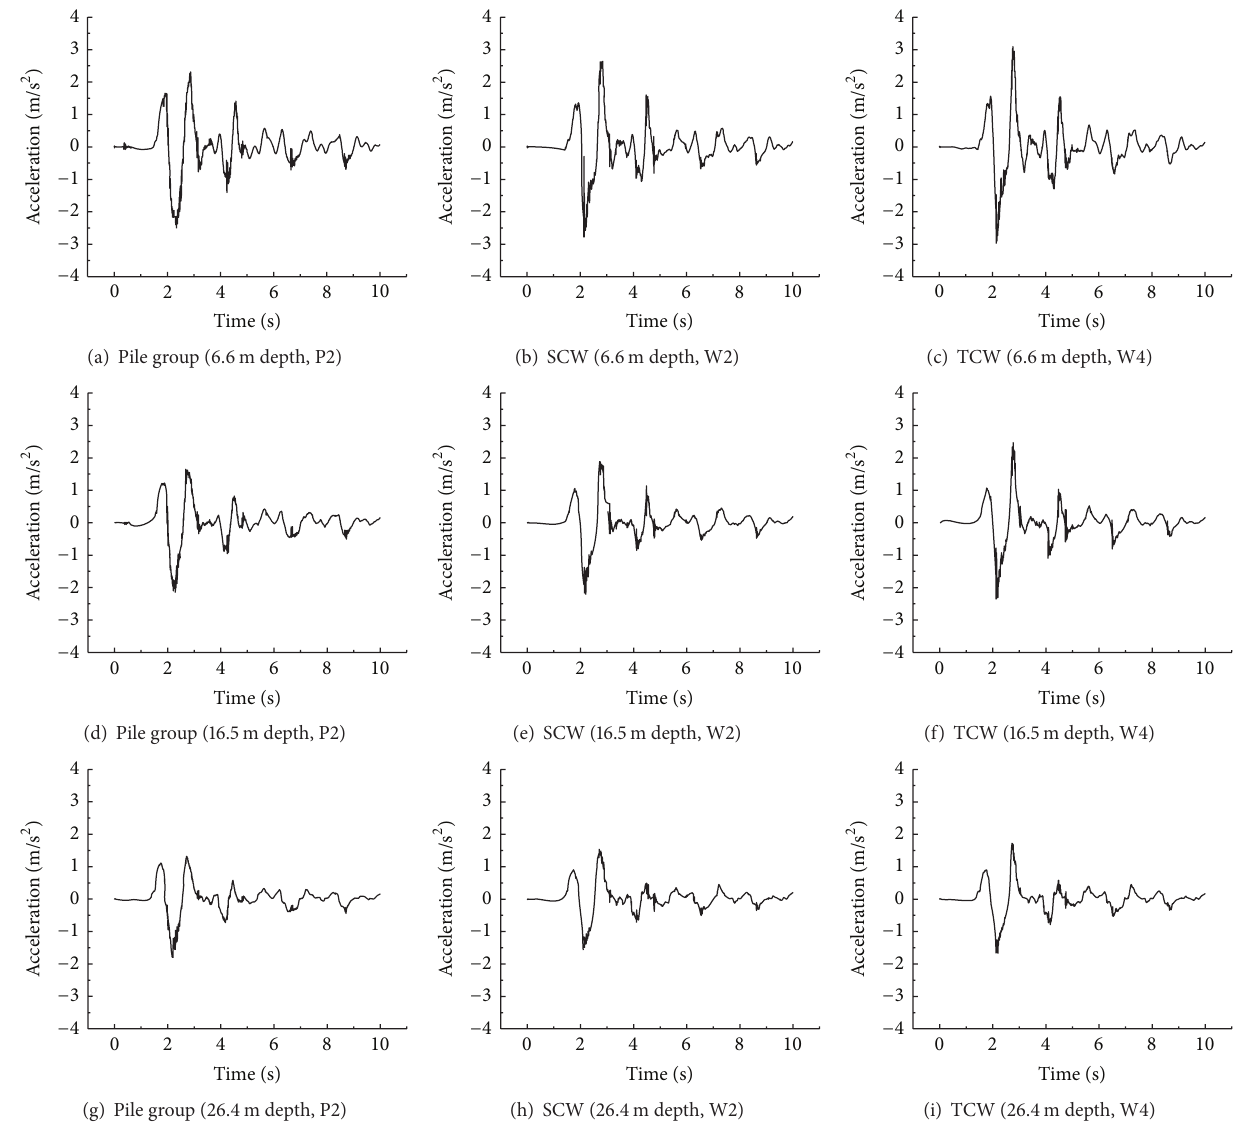
Figure 15: Acceleration time histories at different depth for three